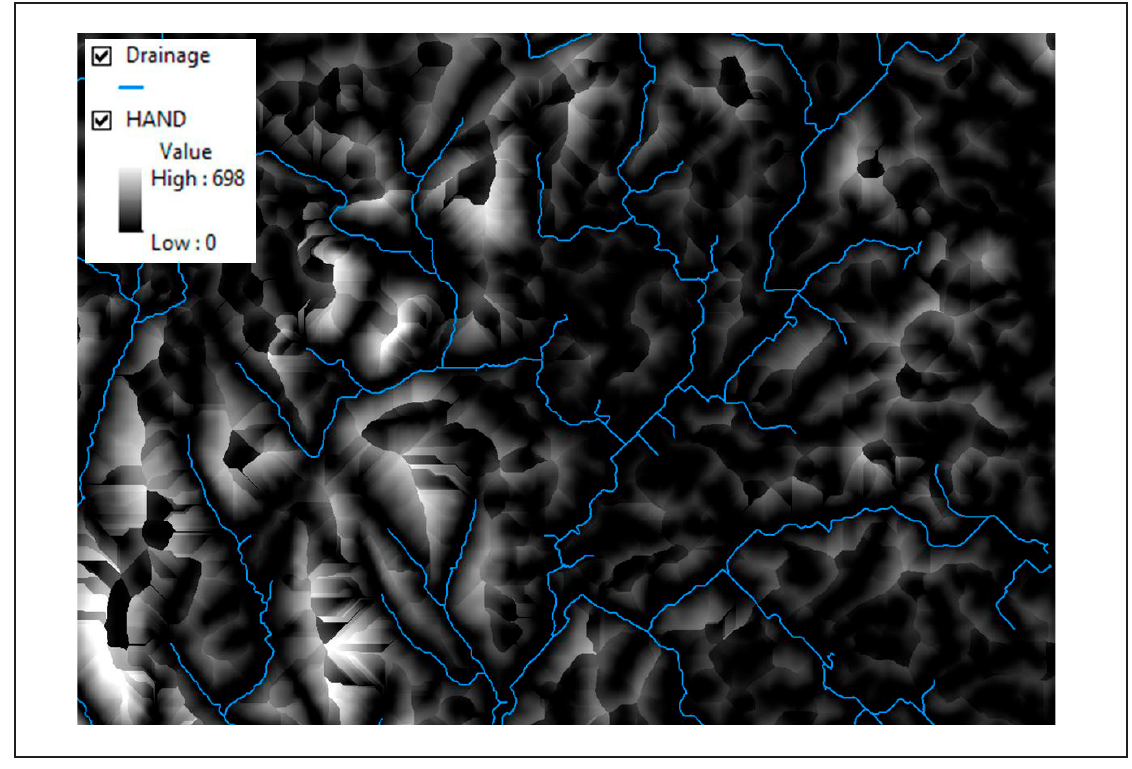
Figure 2 - Result of the HAND raster of Conceição do Castelo